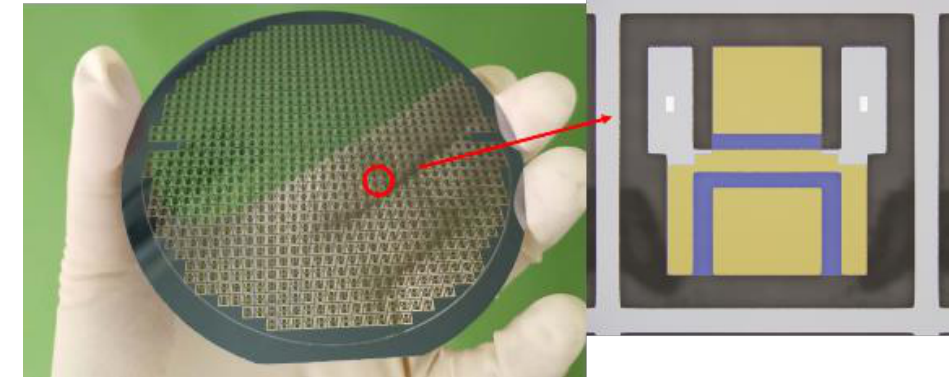
Figure 4. Picture of composite wafers.